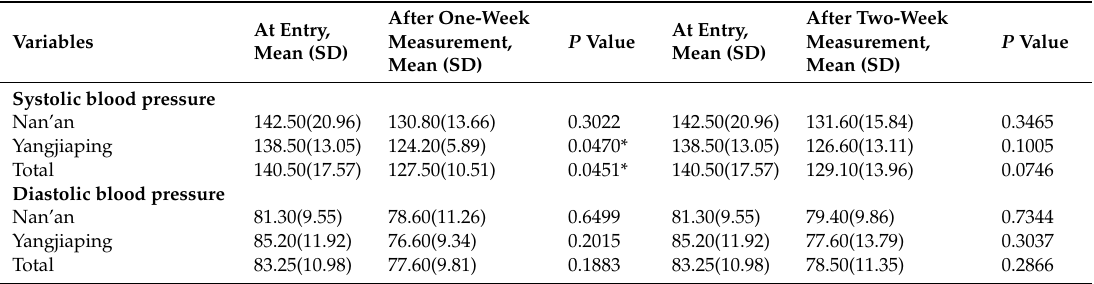
Table 3. Impact of the two-week measurement on patients’ blood